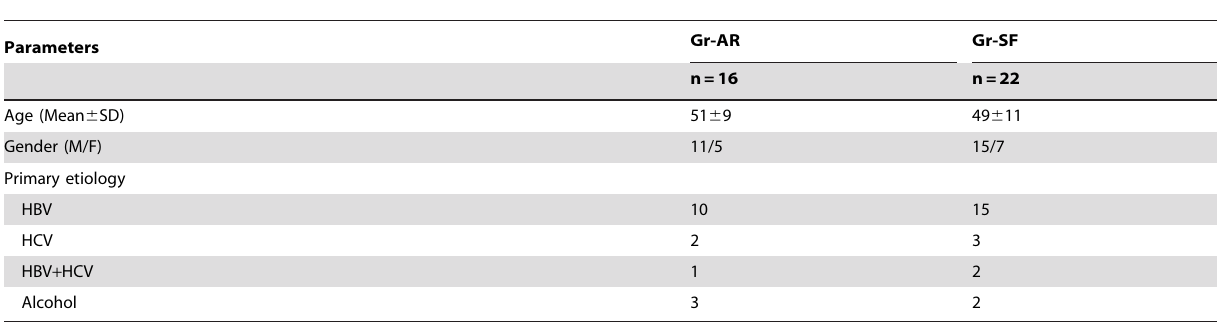
Table 1. Characteristics of